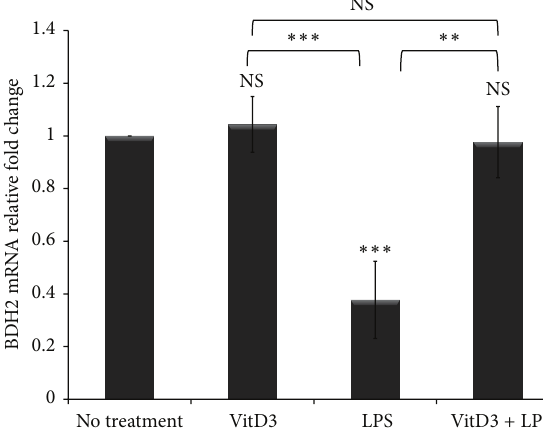
Figure 7: Vitamin D pretreatment protects BDH2 expression in LPS-stimulated macrophages. THP-1 macrophage-like cells ( 1 × 10 6 cells/mL) were treated with 20 nM of 1,25(OH) 2 D 3 , the hormon- ally active form of vitamin D 3 , overnight prior to LPS exposure (40 ng/mL) for 6 hr. RNA was extracted and BDH2 gene expression was assessed by quantitative RT-PCR normalized to 𝛽 -actin. The fold change in BDH2 gene expression was calculated in reference to DMSO treated control THP-1 cells using the ΔΔ CT method and presented here normalized to no treatment control. VitD 3 : 1,2(OH) 2 D 3 . Error bars represent the SD from the mean of three independent experiments. 𝑃 values were calculated in reference to vehicle treatment using one-way ANOVA followed by Bonferroni multiple comparisons post hoc analysis. 𝑃 values annotated ∗∗∗ 𝑃 < 0.0001 ; ∗∗ 𝑃 = 0.001 – 0.01 ; 𝑃 > 0.05 were not significant